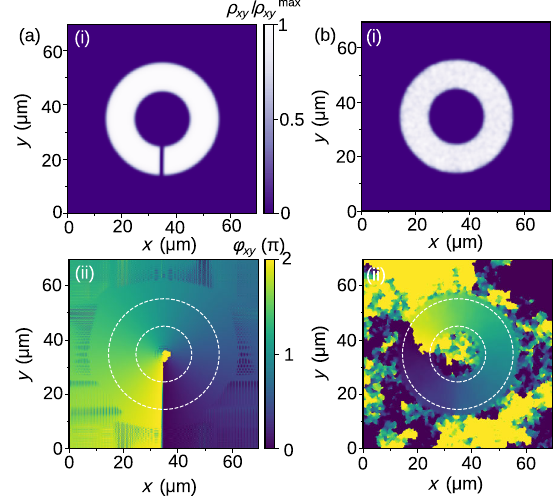
FIG. 7. Superfluid density (i), normalized to its maximum value, and its phase (ii) in the x , y plane at z ¼ 0 : (a) immediately 2 π , and (b) after 1-s evolution time. after the imprinting of Δ ϕ I ¼ The density depletion in (a-i) is due to the finite width of the imprinting potential step. The dashed white circles in the phase profiles indicate the ring edges, where the superfluid density takes its bulk